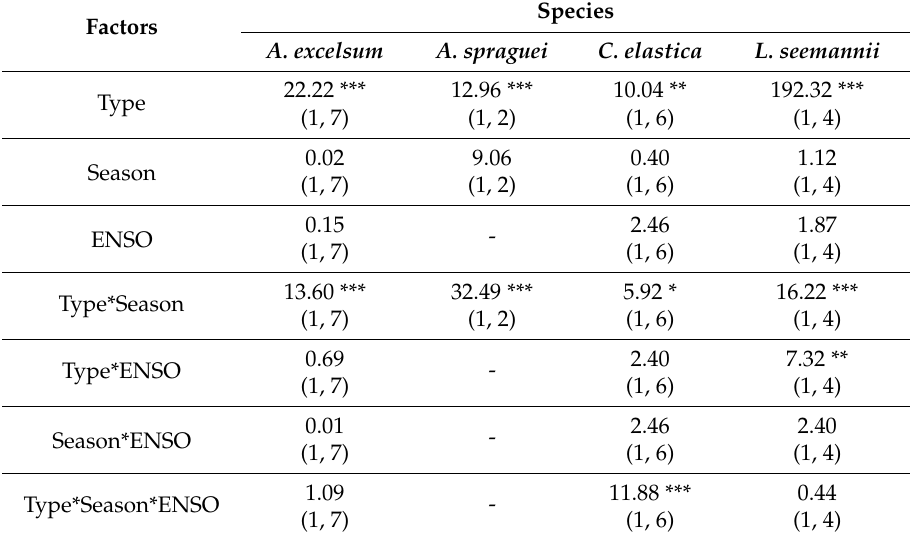
Table 2. Effect of the leaf type (tree or liana leaf), season, ENSO, and their interaction on the displayed temperature of leaves of/on host tropical trees. Values represent F-ratios , values in parentheses describe the degree of freedoms, and the asterisks represent the significance: * p < 0.05; ** p < 0.01, *** p < 0.001.